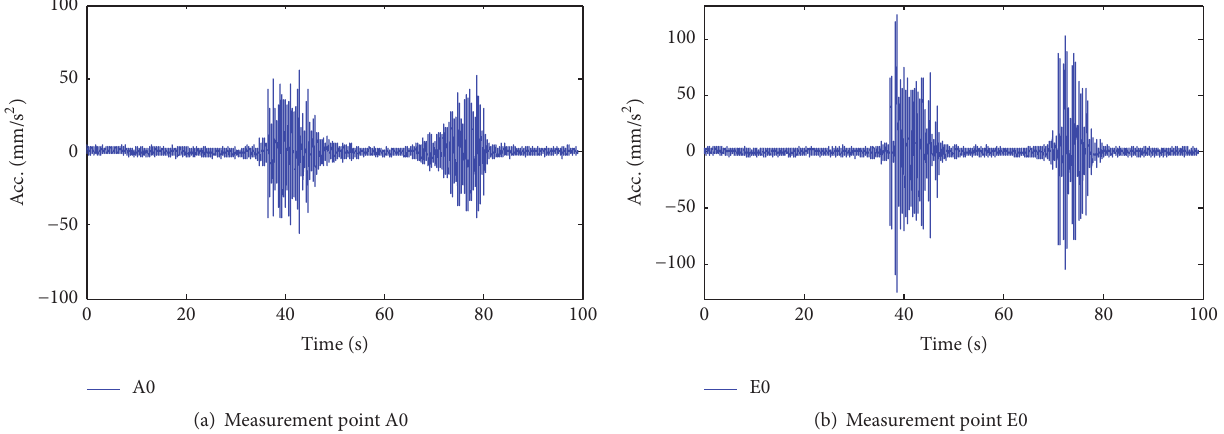
Figure 4: Structural vibration acceleration time history of sampled measurement points.